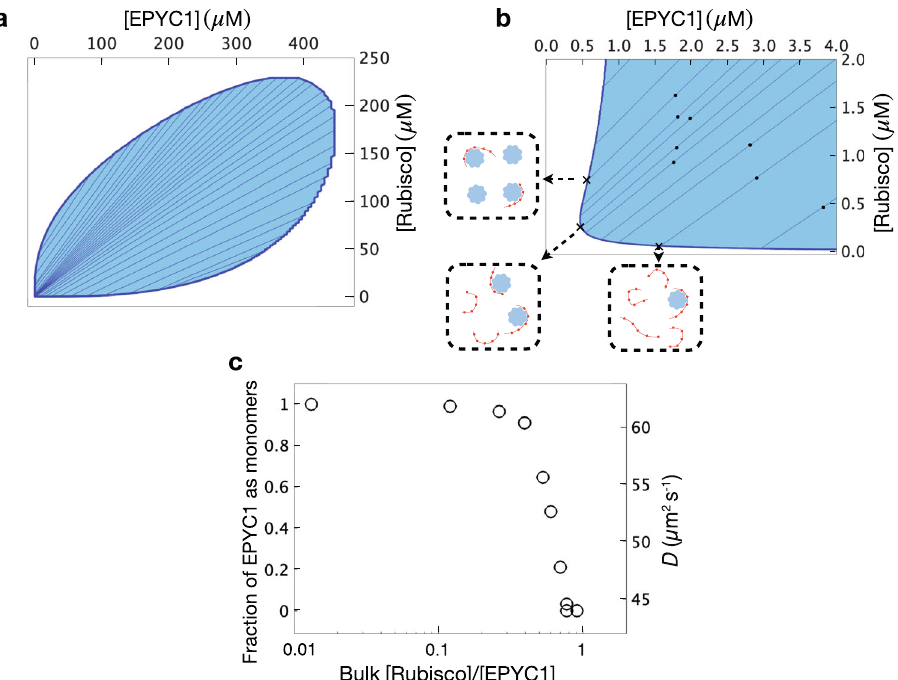
Fig. 4 Predictions of a minimal model for the EPYC1-Rubisco system. a The full modeled phase diagram is shown as a function of total concentrations of EPYC1 polymers and Rubisco holoenzymes. The two-phase region is shaded and each internal tie line connects the dense and dilute phases corresponding to all bulk concentrations along that line. b Zoomed-in version of the phase diagram showing the same range as the experiments in Figs. 1c and 3c. The boxes outside of the middle panel illustrate the contents of the dilute phase at the marked points on the dilute-phase boundary. c The fraction of EPYC1 in the dilute phase that are monomers, and the corresponding semi-empirical prediction for the EPYC1 diffusion coef fi cient as functions of the overall concentration ratio of Rubisco and EPYC1 for the black dots in b which were chosen to closely match the experimental concentrations in Fig.